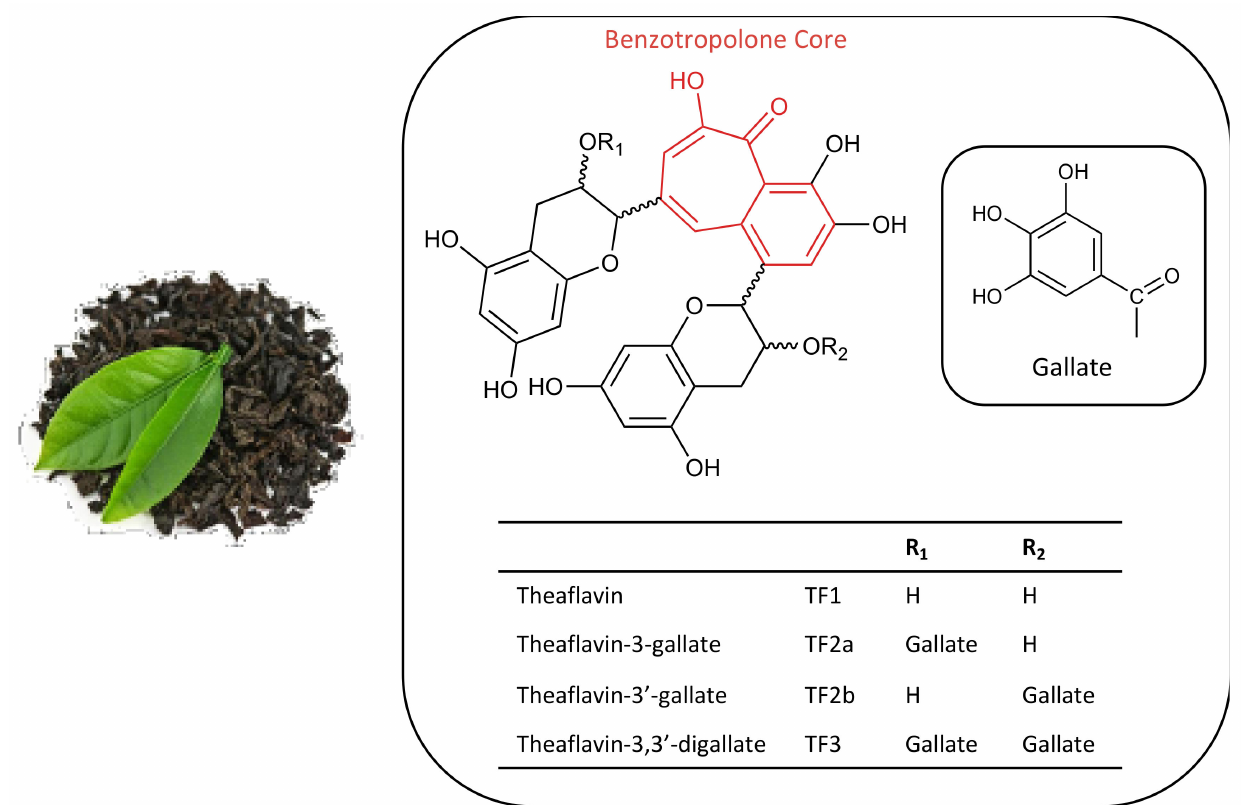
Figure 1. Structure of theaflavins found in black tea. The structure of theaflavin consists of a benzotropolone core (shown in red) formed from the dimerization of a catechin with a gallo-catechin. The theaflavins have two variable R-groups which are substituted with hydroxyl or gallate forming the four main theaflavins: theaflavin (TF1), theaflavin-3-gallate (TF2a), theaflavin-3 (cid:48) -gallate (TF2b), and theaflavin-3,3 (cid:48) -digallate